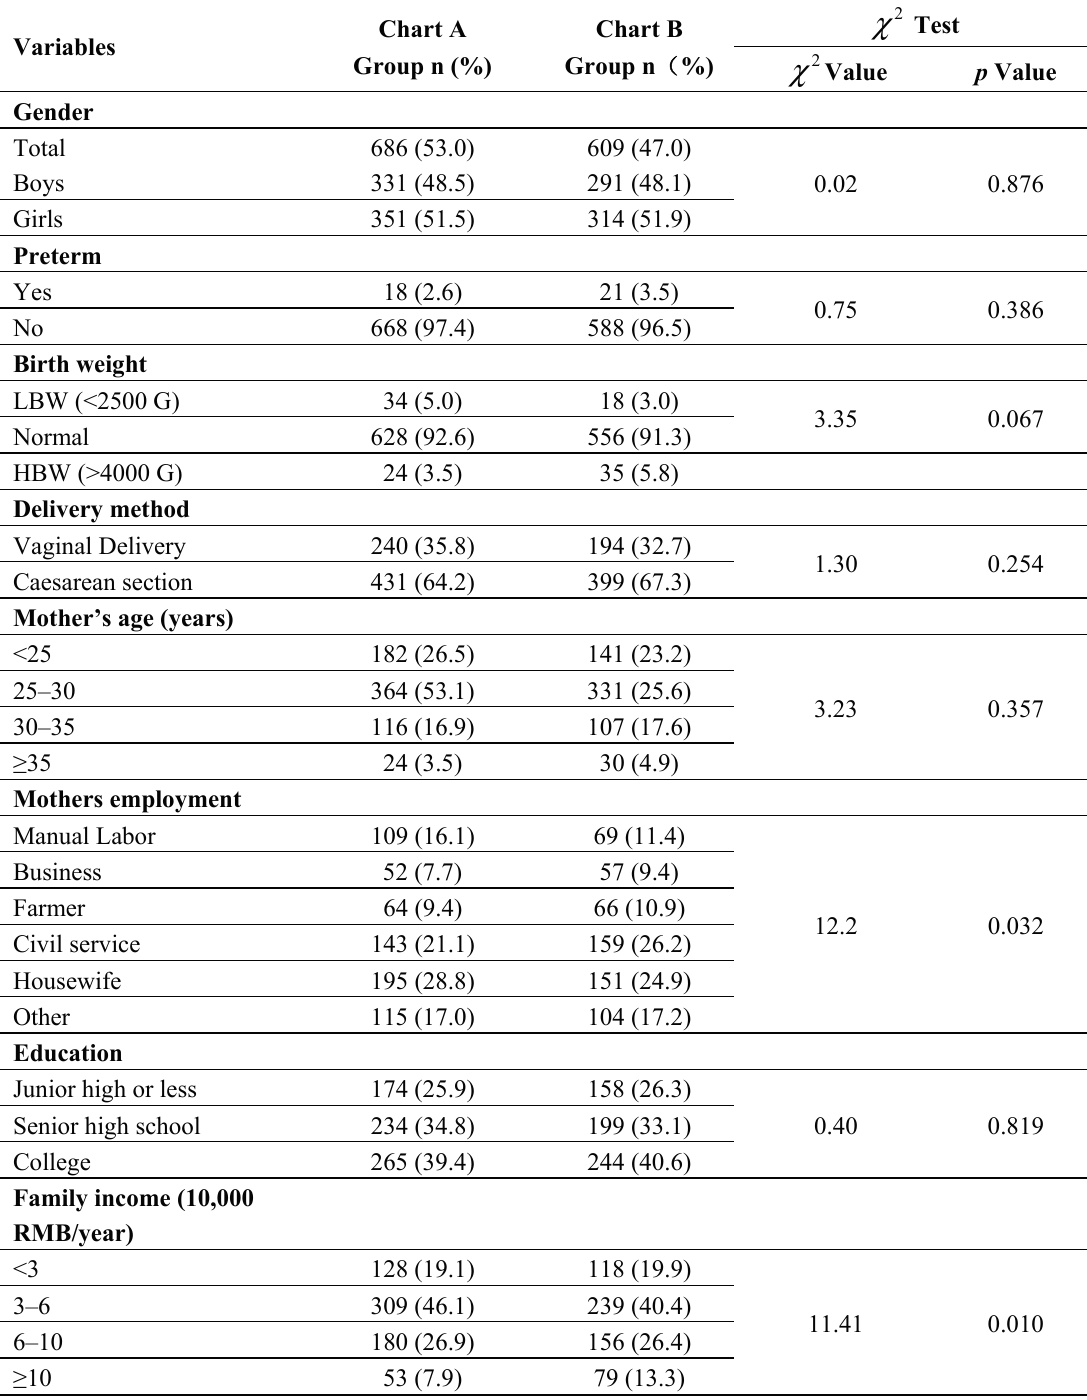
Table 1. Demographic characteristics of the two groups and univariate